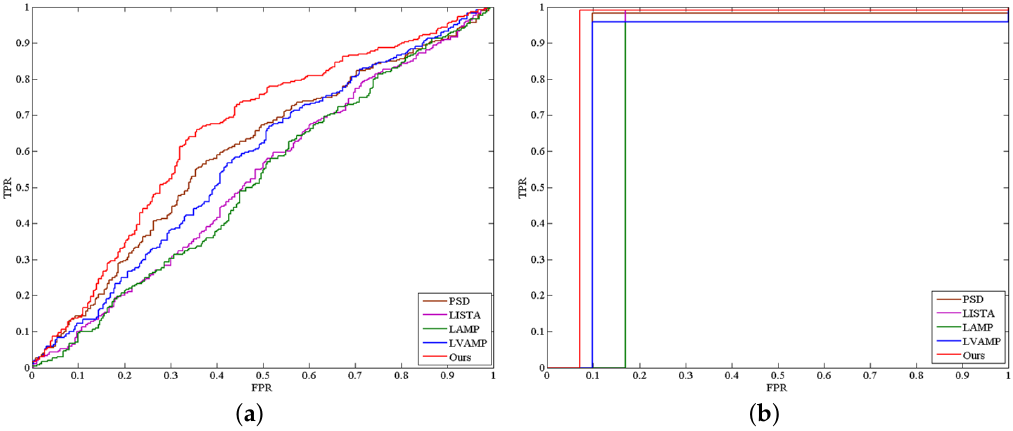
Figure 6. The receiver operating characteristic (ROC) curves of the approximate methods. ( a ) Madelon. ( b )